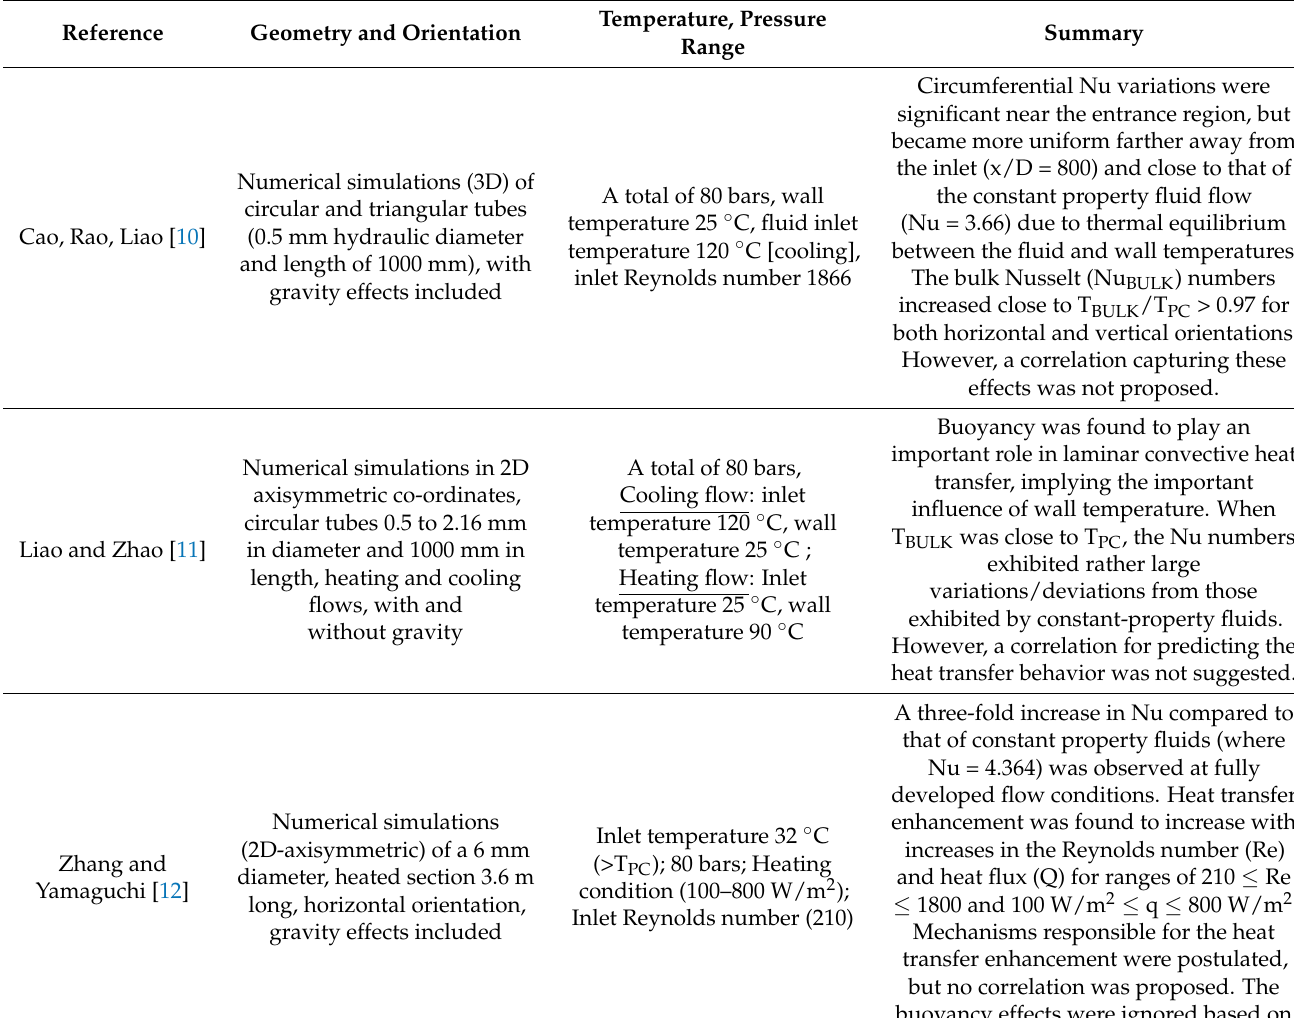
Table 1. A summary of previous studies examining the effects of buoyancy on the laminar heat transfer to sCO